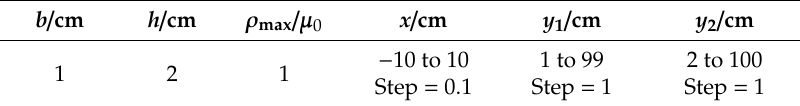
Table A3. The parameter list of MATLAB finite element calculation in Figure